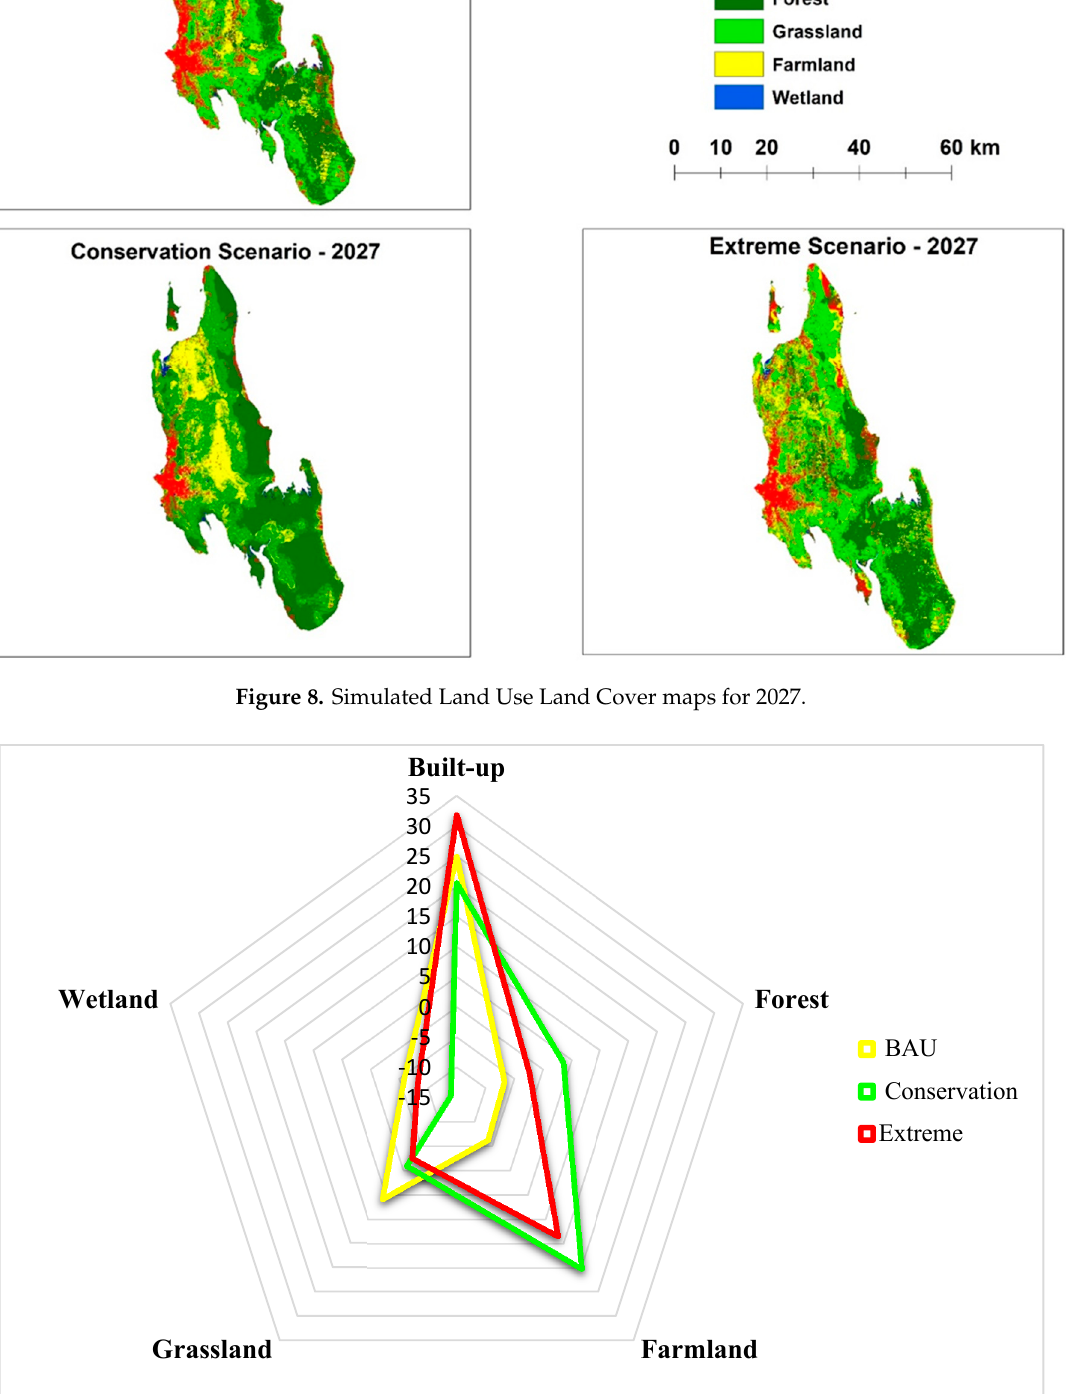
Figure 9. Comparisons of Land Use Land Cover changes (%) from 2018 to 2027 for all scenarios.